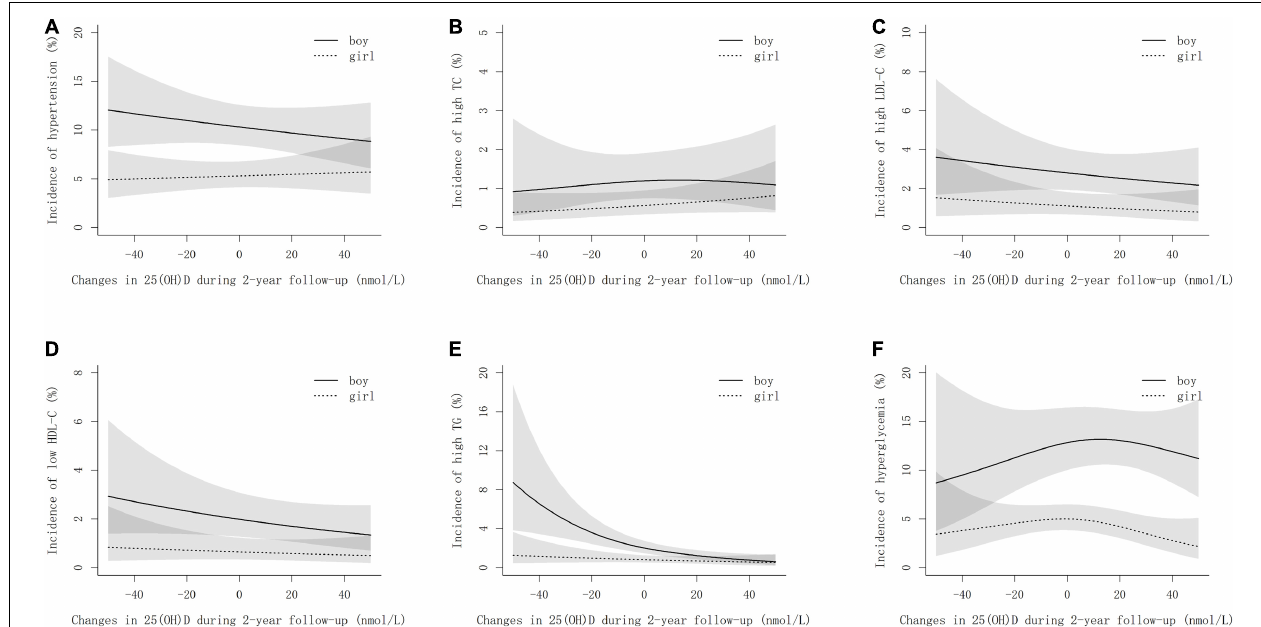
FIGURE 2 | Non-linear associations between the incidences of cardiometabolic risk factors and changes in 25(OH)D during follow-up by sexes. (A–F) stand for hypertension, high TC, high LDL-C, low HDL-C, high TC, and hyperglycemia, respectively. The models are adjusted for age, smoking, drinking, physical activity, dietary habits, BMI, family history of cardiometabolic risk factors, vitamin D supplements, sexual maturity, and baseline cardiometabolic parameters. Changes in 25(OH)D are determined by 25(OH)D concentrations at follow-up minus that at baseline.